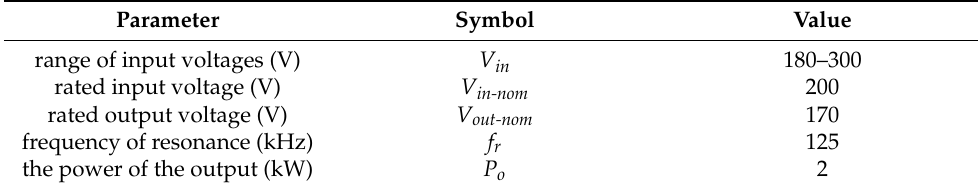
Figure 5. Experimental prototype. Table 1. Specifications of the converter.